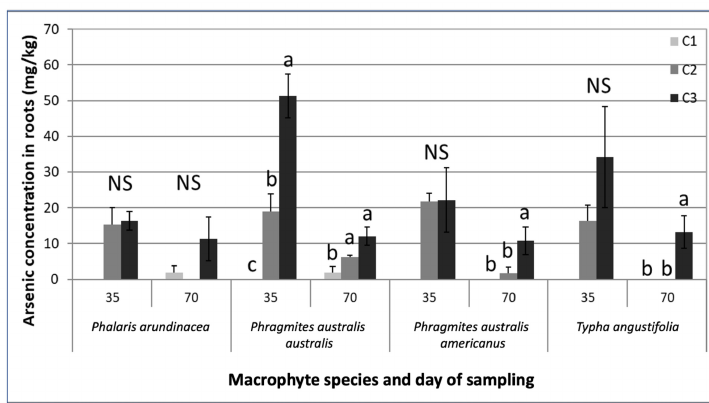
Figure 2. Mean (with standard error) arsenic concentration (mg / kg of DW) in the belowground parts of the four macrophyte species exposed to the contaminated leachates (concentrations C1–C3 ) after 35 and 70 days. For a given sampling date, mean values with identical letters were not significantly di ff erent according to the Tukey HSD test, α < 0.05. ( NS ) No significant di ff erence between mean values across the three treatments for a given sampling